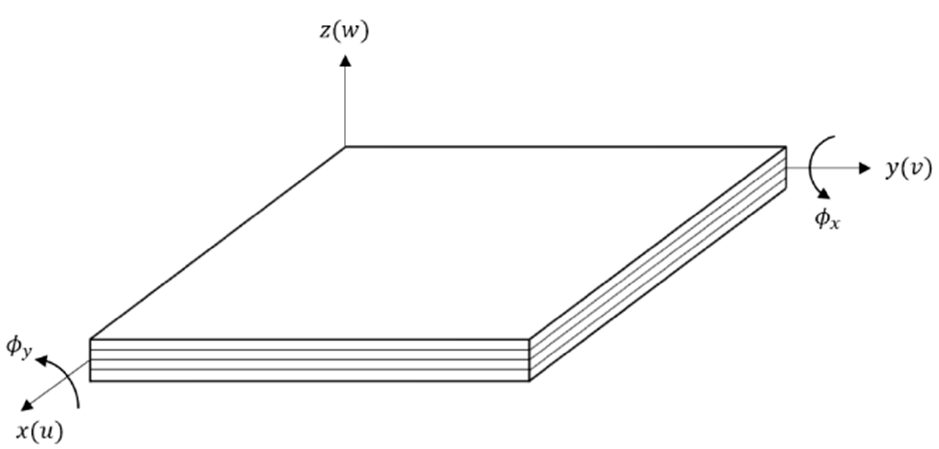
Figure 1. Coordinates of laminated composite plate.